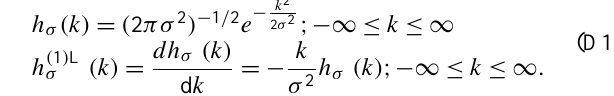
Figure C1. Left panel: frequency response of an SG2 filter with N = 5, which exhibits unwanted side lobes (blue line). This prob- lem is practically removed using a Blackman-type window. The re- sulting SG2-windowed filter frequency response (red line) shows an efficient suppression of the high frequencies, but it has an enlarged transition band (about a factor of 2, for any N)